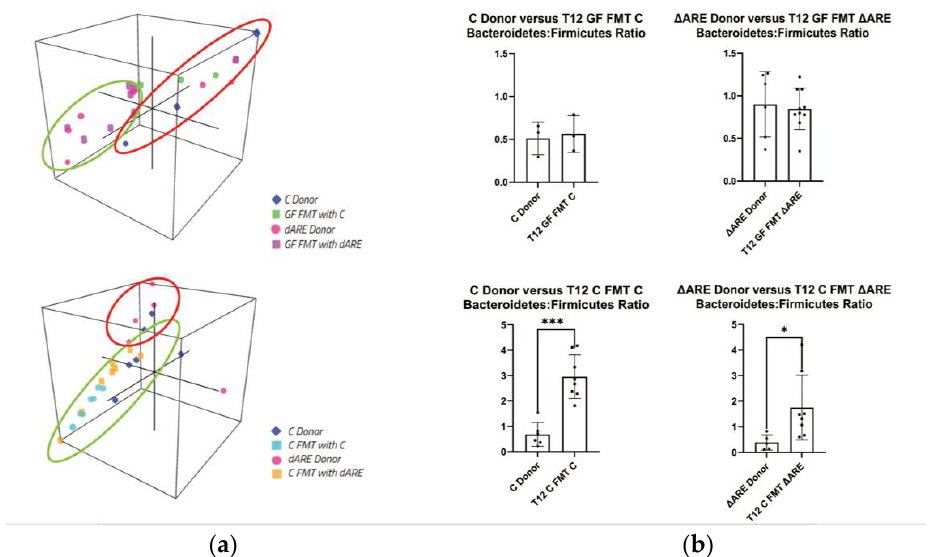
Figure 5. 3D visualization of phyla communities in FMT colonies and quantification of Bacteroide- tes/Firmicutes ratio. GraphPad Prism was used to generate the bar plots that shows the mean of data and error bars show standard deviation. Stars represent significance (* for p < 0.05, ** for p < 0.01 and *** for p < 0.001). Taxonomy panel at Phyla level. Panel ( a ) 3D representation of clustering at the Phyla level. Top: Donors ( n = 9) and GF mice FMT with Controls or TNF ΔARE+/− ( n = 13). Clus- tering indicates that GF recipient mice are localized closely to their respective donor mice together. Bottom: Donors ( n = 11) and GF mice FMT with Controls or TNF ΔARE+/− ( n = 16) — Clustering indicates that C donors, C mice FMT with C, and C mice FMT with TNF ΔARE+/− are localized apart from TNF ΔARE+/− donors. TNF ΔARE+/− donors are clustered together, but far apart from other groups, indi- cating a unique 3D localization and microbial profile. Panel ( b ) Firmicutes/Bacteroides ratio. Top: Comparison between donors and GF mice FMT with their respective donors. No statistical differ- ence is observed in the B/F ratio for C donor ( n = 3) vs. GF FMT C ( n = 3) and for TNF ΔARE+/− donor ( n = 6) and GF FMT TNF ΔARE+/− ( n = 10). Bottom: Comparison between donors and Control conven- tional, healthy mice recipients. Two- way student’s t -test statistical analysis indicates a significant